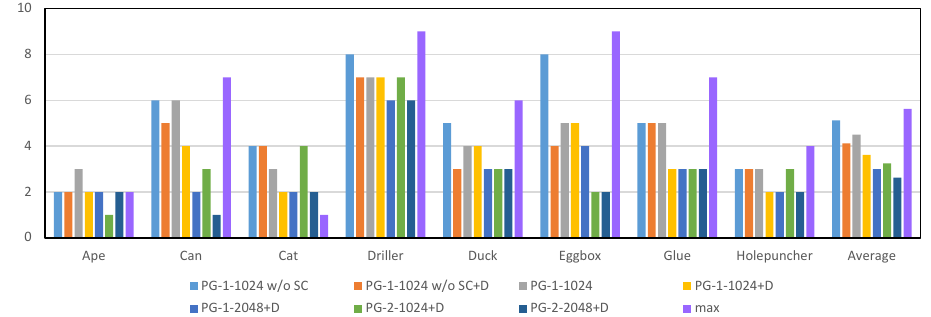
Figure 4. Statistics of false projection selection per one hundred channels for different configurations on parts of the LineMOD dataset [18]. A typical configuration can be expressed as PG-x-y w/o SC+D, where PG denotes the abbreviation of projection grouping module, w/o SC indicates that the network doesn’t contain shortcut connection (SC), D is the dropout layer, x and y represents the number of fully connected layers and dimensionality of the output space, respectively. max refers to the strategy utilized in DeepHMap. For results shown in figure, lower is